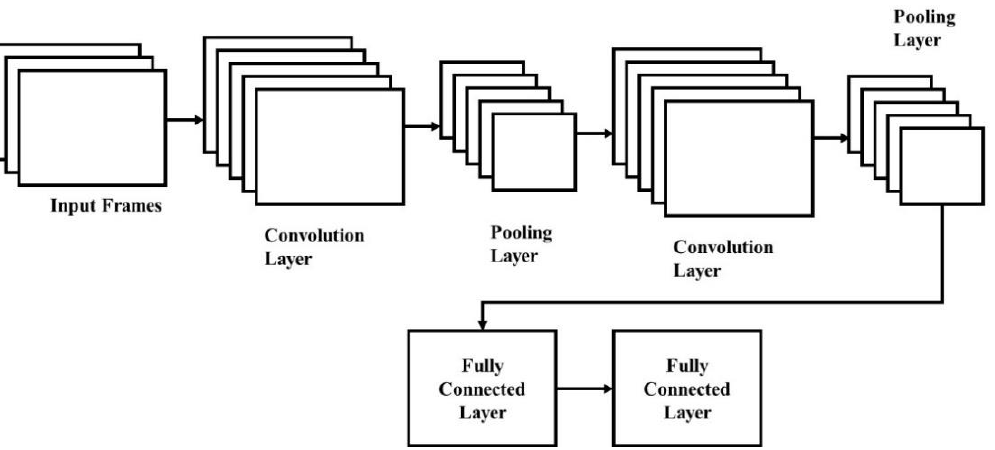
Figure 2. CNN model architecture.